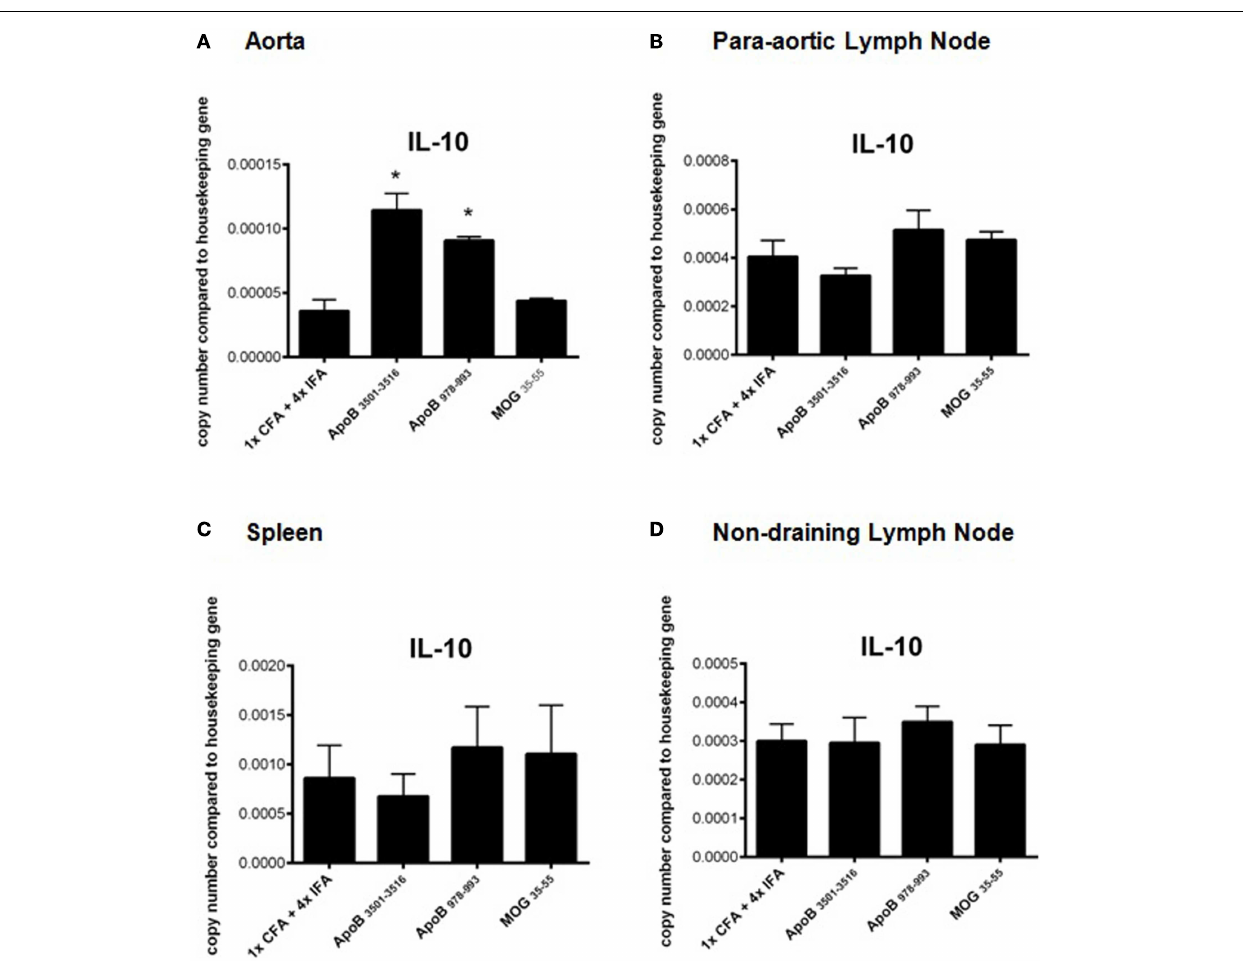
FIGURE 4 | Real time RT-PCR analysis of IL-10 mRNA expression . Organs were harvested and immediately placed into RNA stabilization reagent, and frozen at − 80 ° C. IL-10 mRNA expression from (A) aortas,